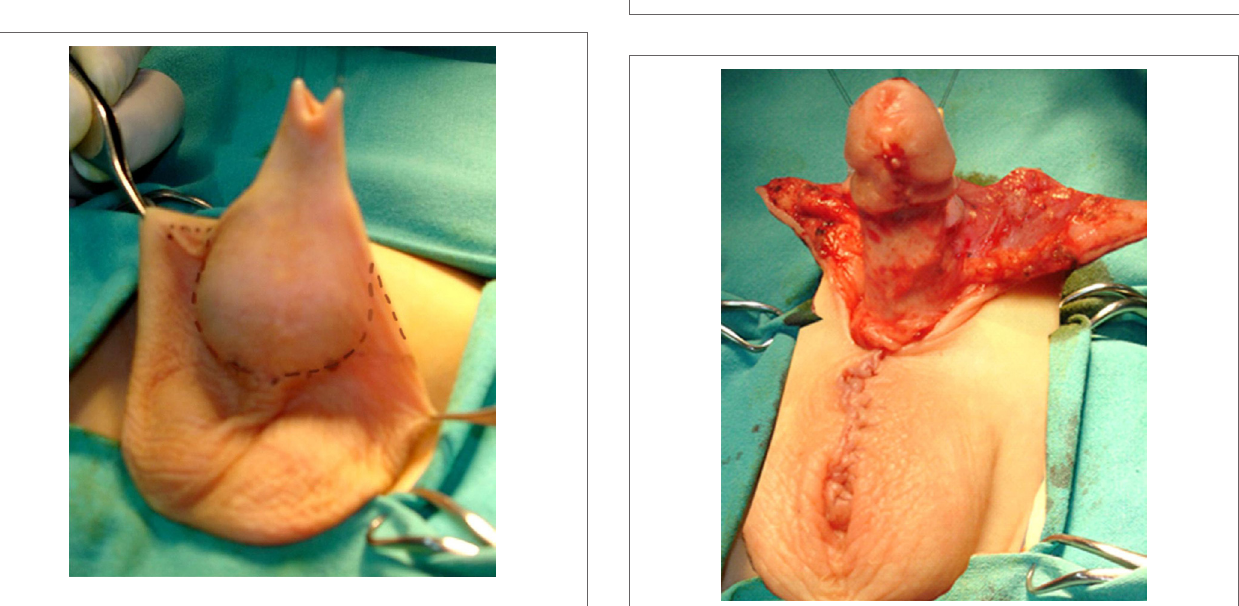
FigUre 2 | Traction in the preputial opening. Before ventral transverse incision, we marked the limit between scrotal and penile skin, which was prolonged laterally, circumscribing the apical scrotal engulfment adjacent to each side of the penile shaft.